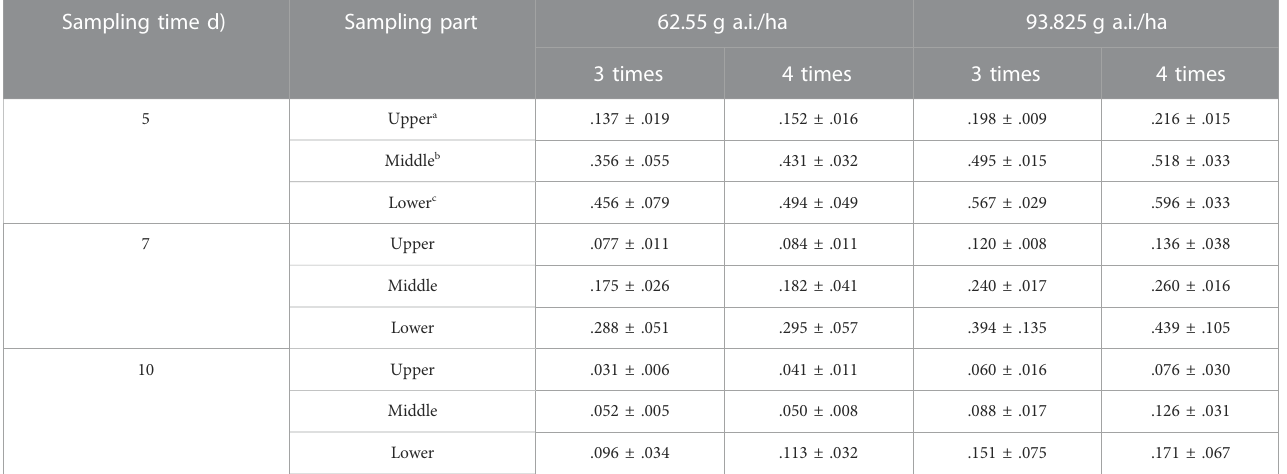
TABLE 5 The terminal residue levels of fl uopyram in cowpea ( n = 3).